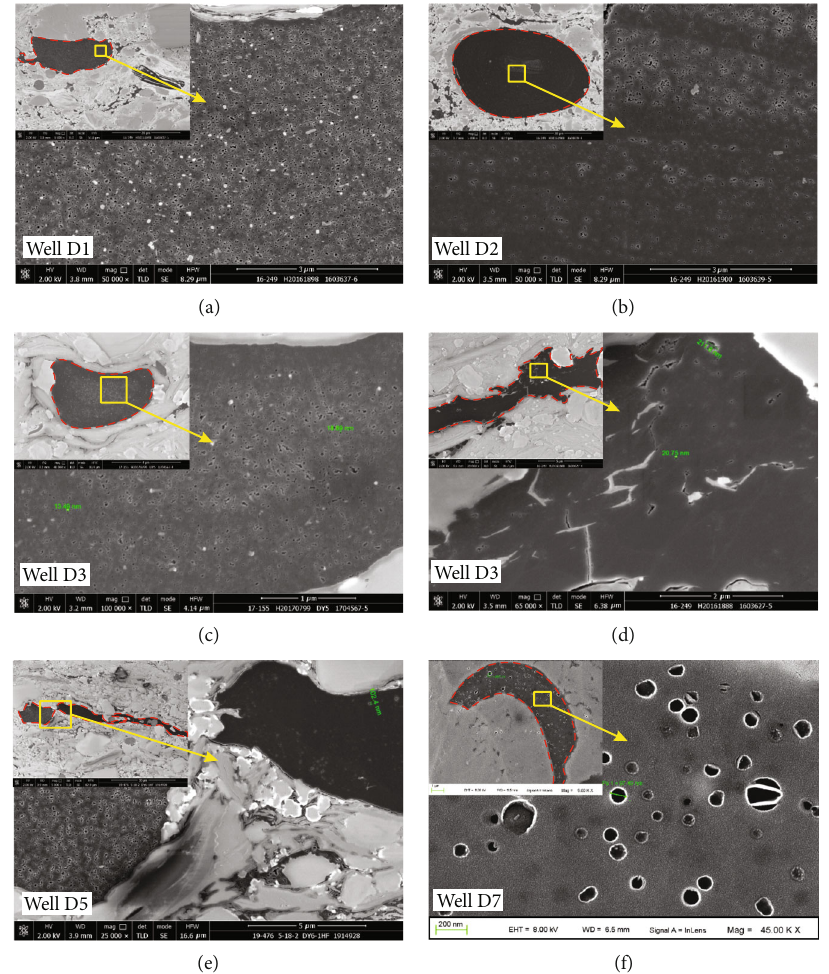
Figure 4: Characteristic of organic matter in situ and their organic matter pores in Longmaxi formation shale in Dingshan fi eld under SEM ((a, c, f) acritarch; (b) algae; (d) plant debris; (e) graptolite